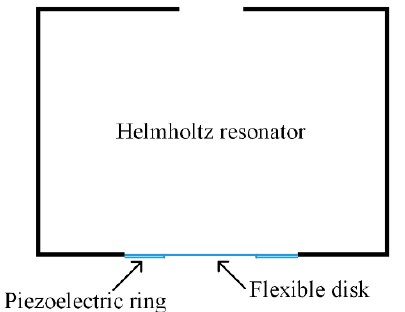
Figure 5. Schematic diagram of a Helmholtz resonator with a compliant bottom; a piezoelectric ring serves as the converter. This represents a MEMS-scale device.